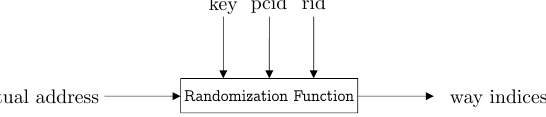
Figure 1: Randomization function of TLBcoat which uses a global processor key and process-related information to generate possible positions inside the